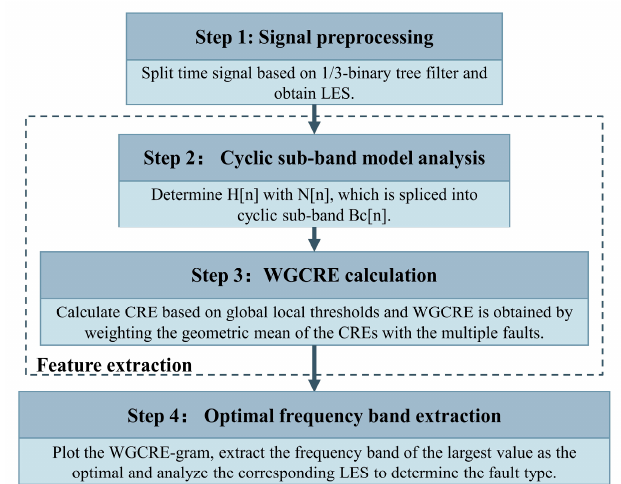
Figure 3. Approach Figure 3. Approach steps.